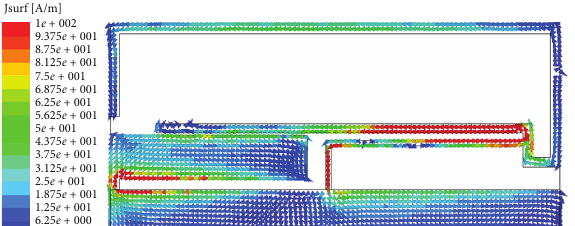
F 7: Surface current distribution simulated on the proposed antenna’s radiator and GND at